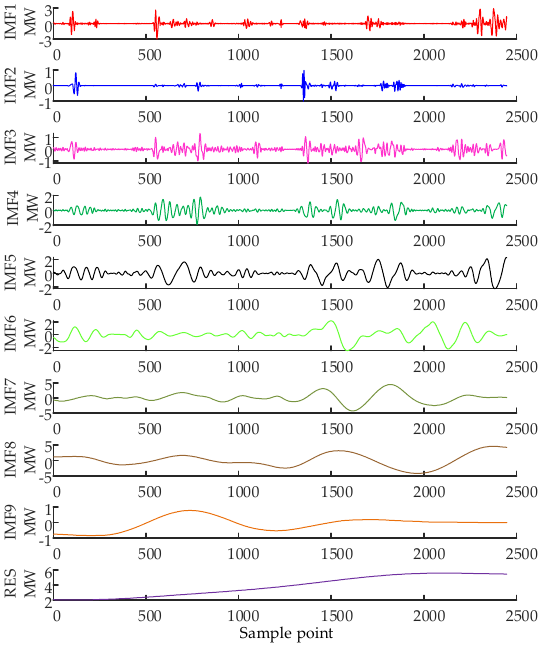
Figure 3. Wind power sequence decomposed by CEEMDAN.